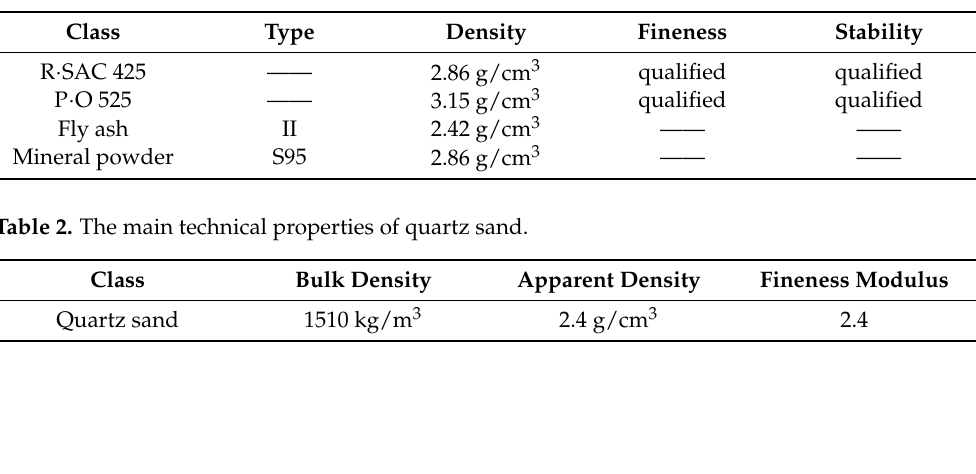
Table 1. The main technical properties of cementitious materials.